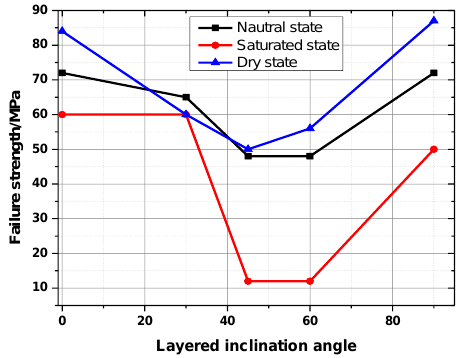
Figure 13. Creep failure strength with layered angles.